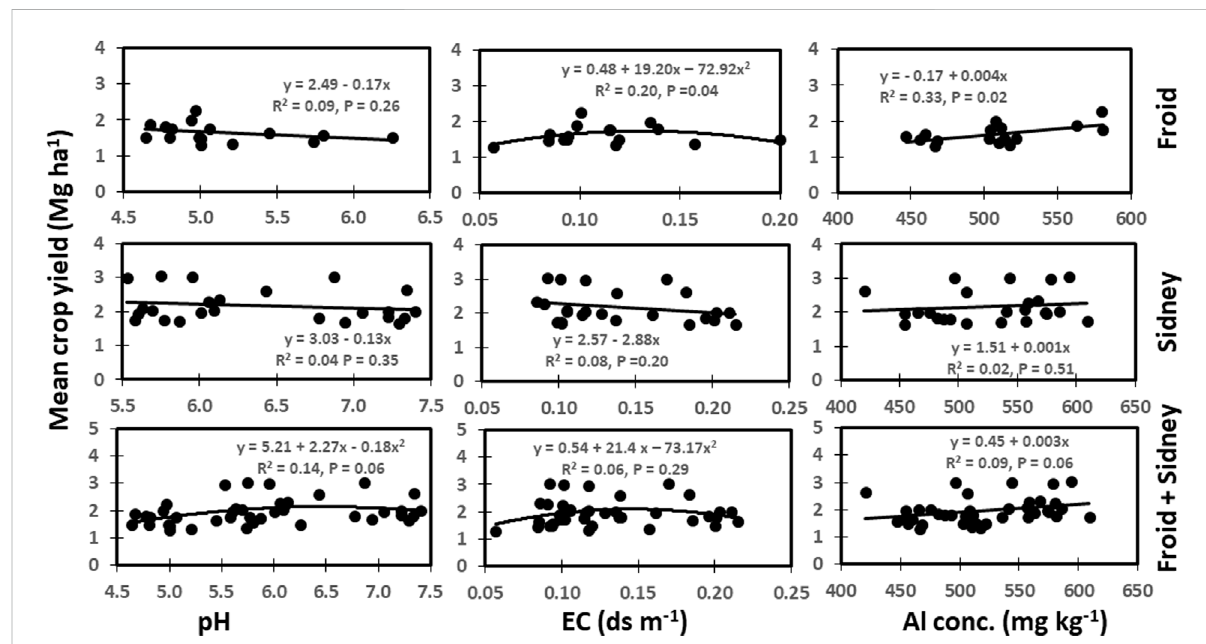
FIGURE 4 RelationshipsamongsoilpH,electricalconductivity(EC),Alconcentration,andmeancropyieldacrossyearsatFroid,Sidney,andthecombined data from Froid and Sidney, Montana, United